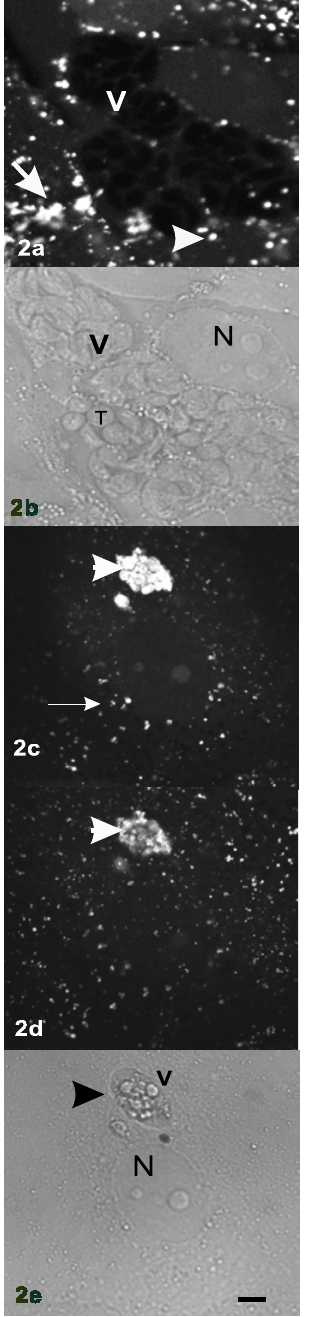
Fig. 2 – Confocal laser scanning microscopy of infected cells in the presence of Acridine Orange (5 µ g/ml) for 30min. Infected cells did not show fluorescence inside PV containing parasites (fig. 2a, b-V). In the presence of hydroxyurea for 24h (fig. 2c-e), fluorescence was observed inside PV containing disorganized parasites (fig. 2e – arrowhead). The fluorescence was indicative of acidification (Rhodomine spectrum, fig. 2c) or indicative of the neutral pH of the PV (Fluorescein spectrum. Fig. 2d). Parasitophorous vacuole: V; Nucleus: N; Tachyzoytes: T. Bar: 5 µ m.